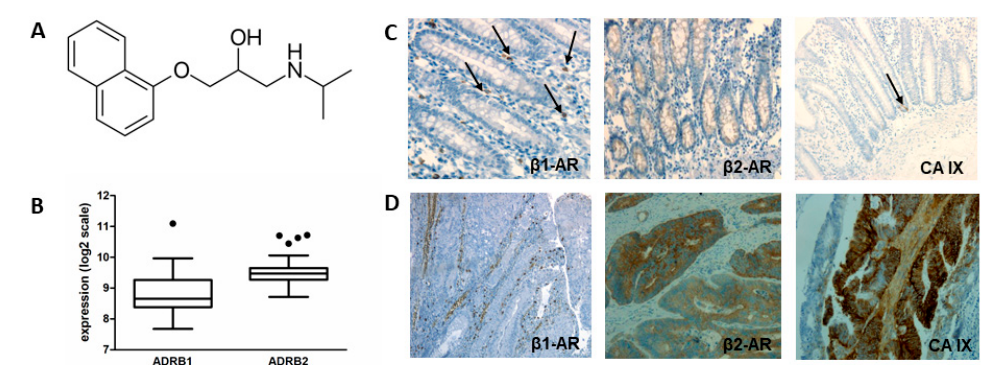
Figure 1. Evaluation of β 1 and β 2-AR expression and immunohistochemical analysis of CA IX and β AR expression in healthy colon ( C ) and colorectal cancer tissue samples ( D ). ( A ) Chemical structure of propranolol. ( B ) Box plot graph of the results of in silico analysis of β 1 and β 2-AR expression in colorectal neoplasms. Using the Genevestigator database we showed expression β 1 and β 2-AR at medium level in tissues derived from colorectal carcinoma. ( C ) The expression of β 1 AR is associated with mastocytes (indicated by arrows) and smooth muscle of vessels in healthy colon tissues, expression of β 2 AR was detected in cryptal cells. Weak expression of CA IX was found in cryptal cells (indicated by arrow). ( D ) The expression of β 1 AR in human colorectal cancer samples was associated with mastocytes and smooth muscle of vessels in non-malignant regions of colorectal cancer (CRC), expression of β 2 AR was detected in malignant cryptal cells. The strong expression of CA IX was localized to the cryptal cells.